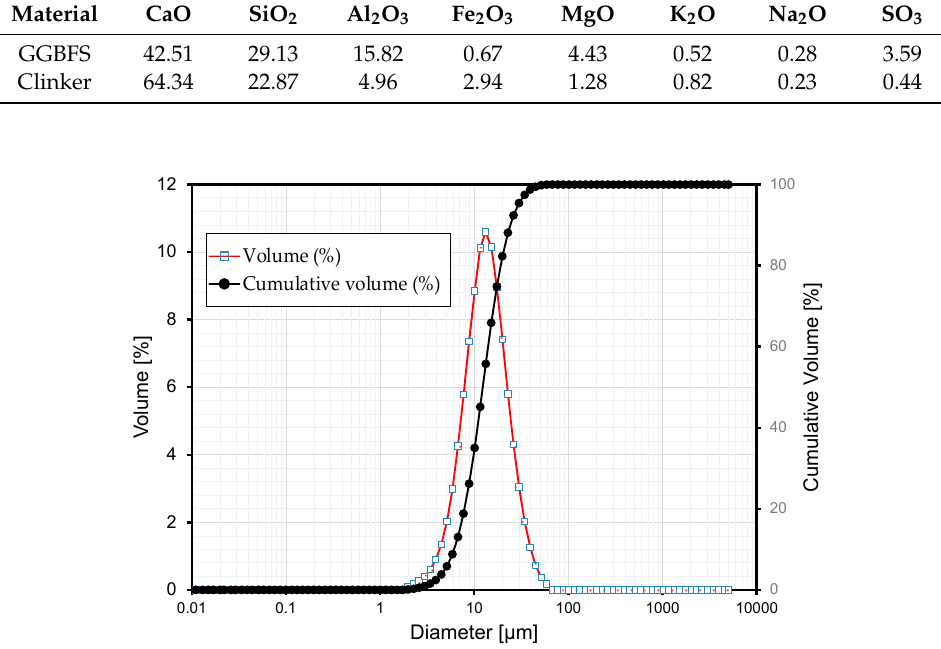
Table 1. Chemical composition of raw materials (in weight ratio).